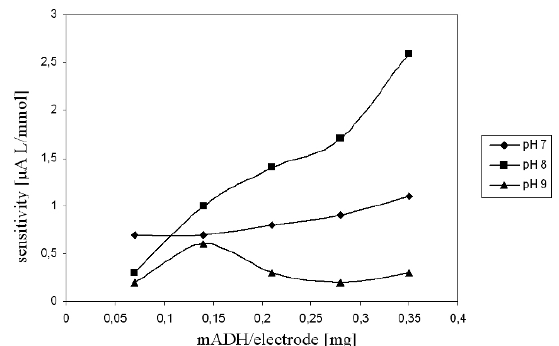
Figure 3. Effect of the amount of ADH immobilized into biolayer and pH of supporting electrolyte on sensitivity of ethanol = -50 mV vs. Ag/AgCl. biosensor; E app.